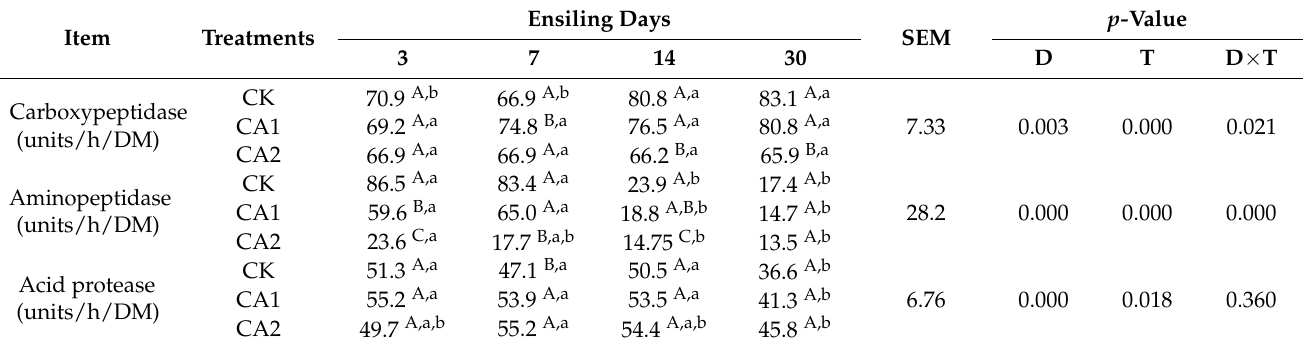
Table 3. The protease activities of mulberry leaf